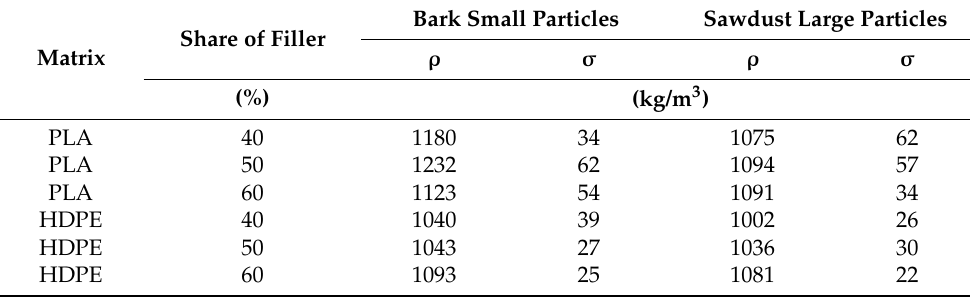
Table 4. The mean density values for individual variants of panels with additives.